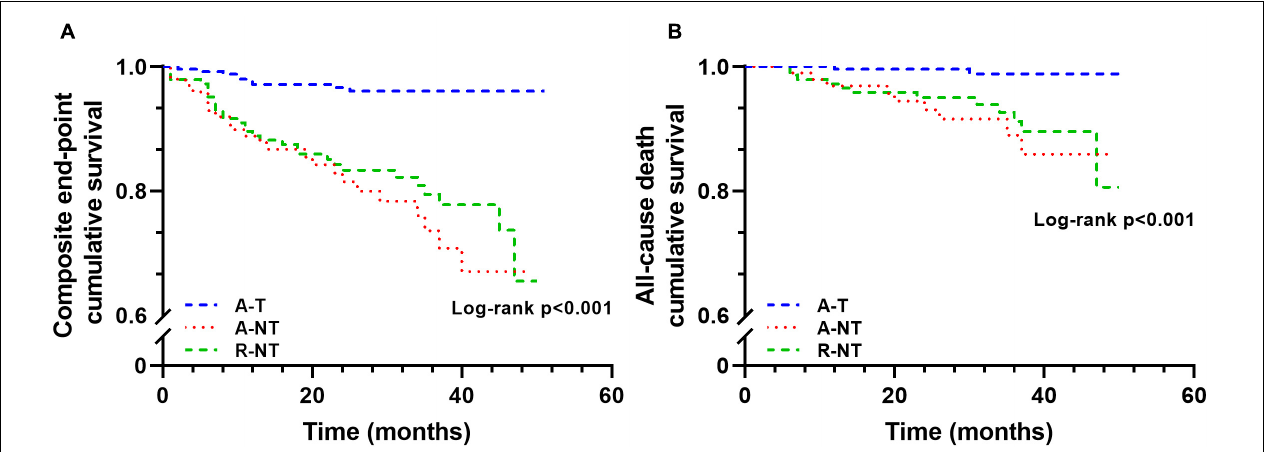
FIGURE 2 | Kaplan–Meier curves for long-term outcome grouped by ET groups ( A , composite endpoint cumulative survival; B , cumulative survival). A-T, Accepted and did exercise training; A-NT, Accepted but did not do/complete training; R-NT, Rejected and did not perform training. The composite endpoint includes all-cause mortality, hospitalization due to ACS, or the need for new revascularization during follow-up.